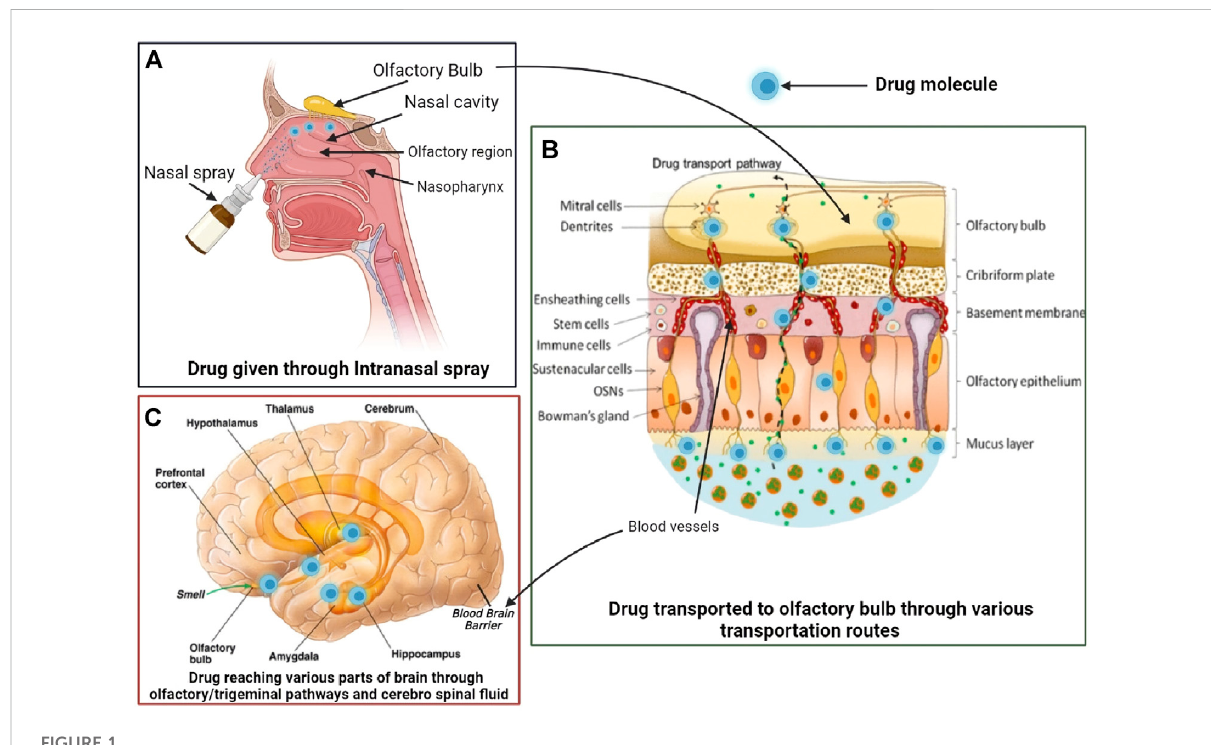
FIGURE 1 Intranasal drug delivery mechanisms for brain